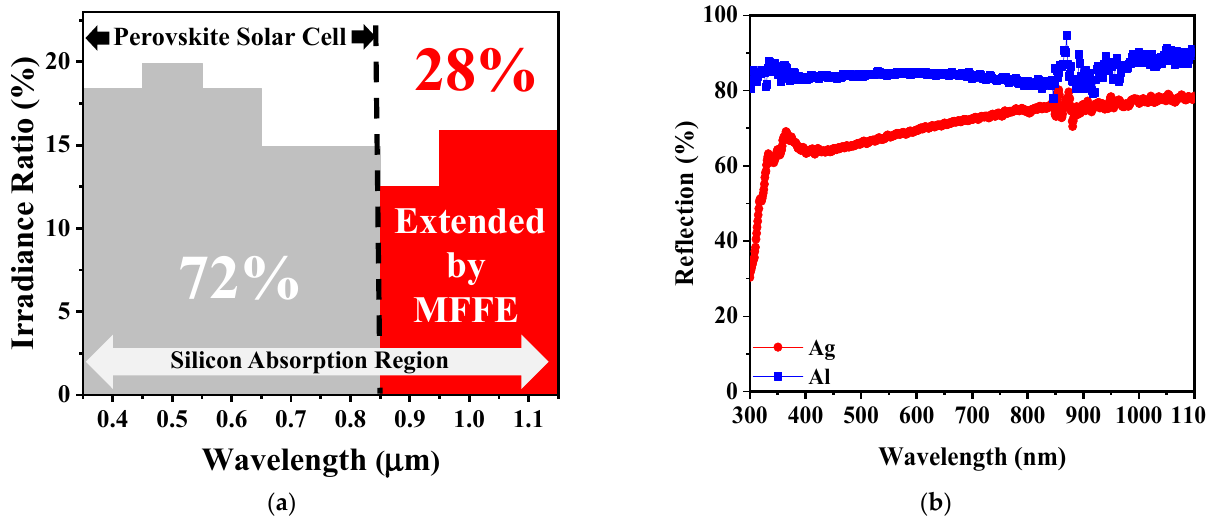
Figure 1. ( a ) The irradiation ratio distribution within AM1.5G. The perovskite solar cell absorbs only 72% of the irradiation spectrum. Combining the multi-functional folded electrode (MFFE) with the perovskite solar cell benefits the harvest of additional near-infrared light energy for enhancing the conversion efficiency further; ( b ) the optical reflection of metal silver (Ag) and that of aluminum (Al). Significantly, the high optical reflection can be observed without optical structure, and silver has the inter-band transition phenomenon (low optical reflection) in the ultra-violet regime.